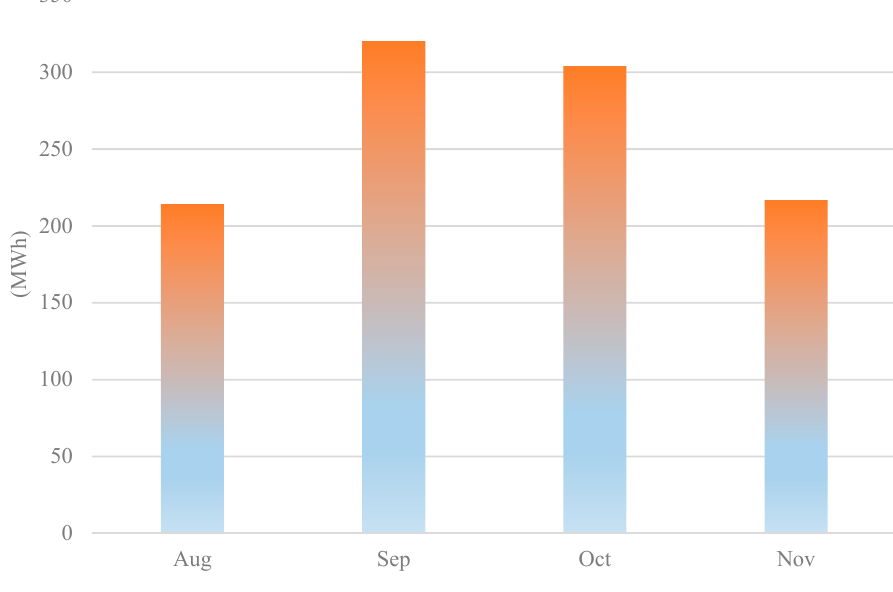
Figure 15. University energy demand.